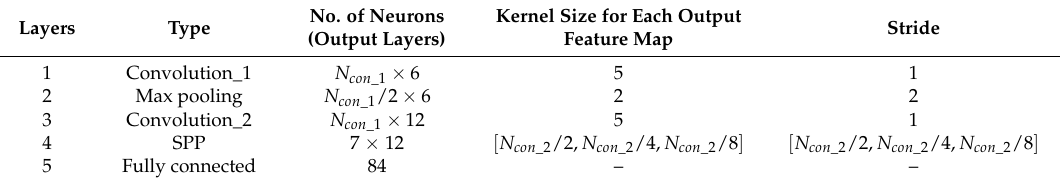
Table 1. The detailed overview of ECG-SPP-net structure.